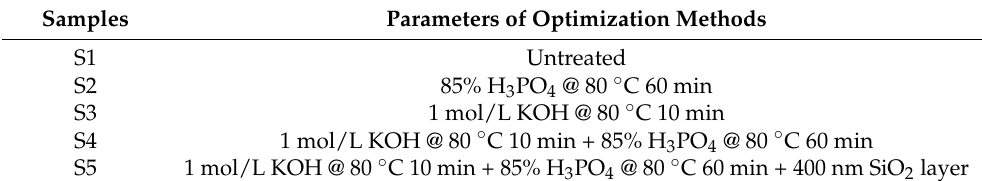
Table 1. Optimization parameters of S1–5 samples. Samples